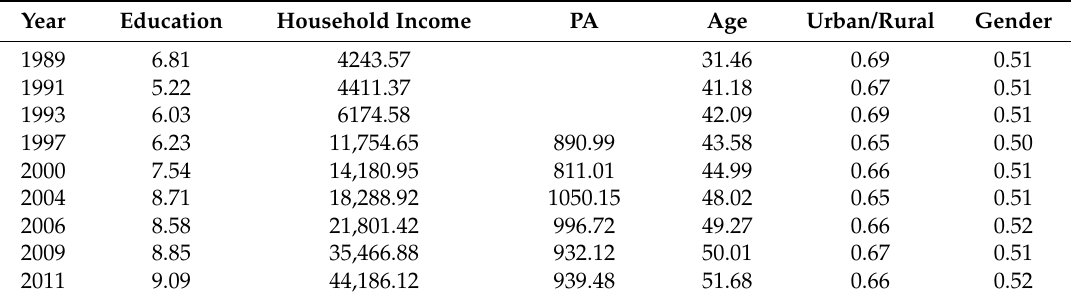
Table 2. Explanatory covariates of panel regressions for